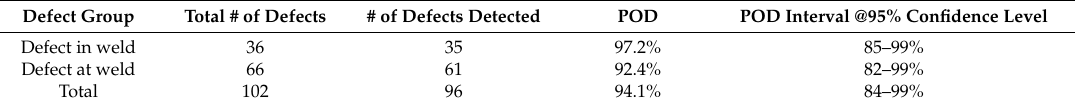
Table 1. Probability of Detection (POD) summary of test results of Girth Weld (GW) crack-like defects.